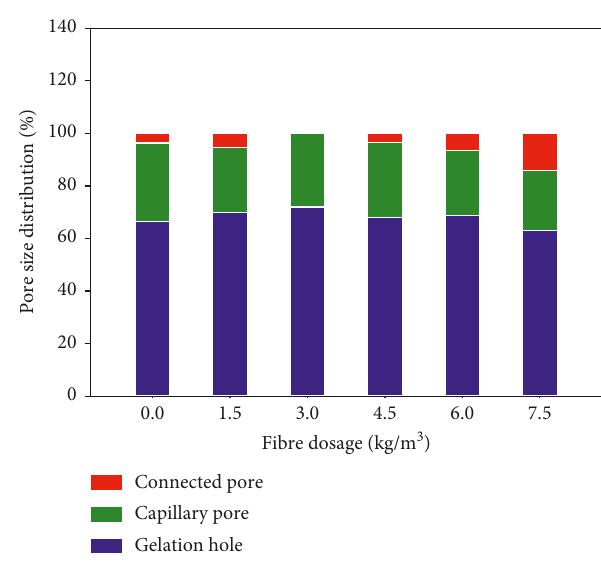
Figure 13: Pore size distribution of three types of